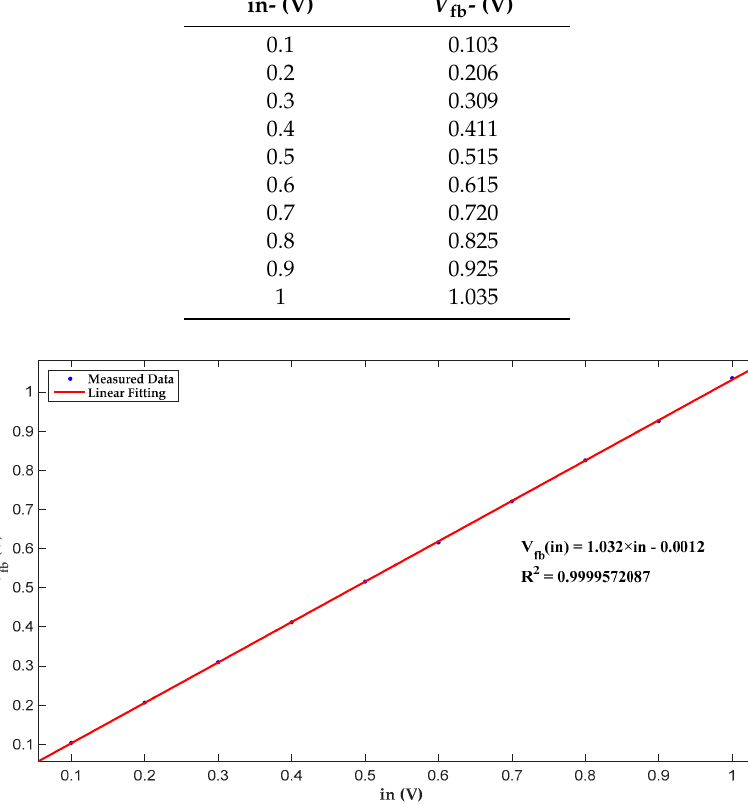
Figure 8. Linear fitting of multiplier simulation results.